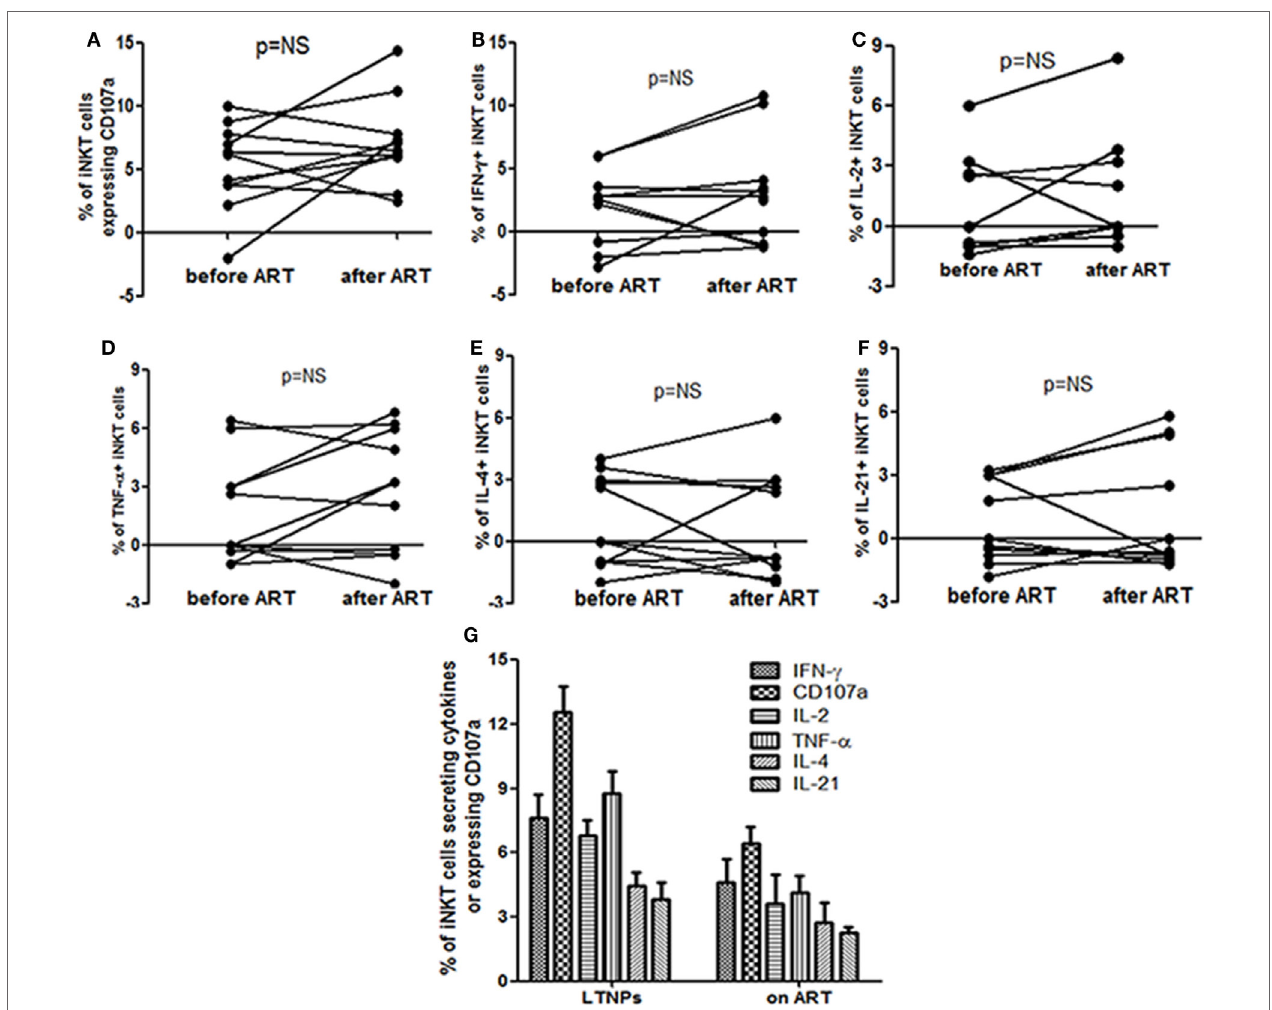
FigUre 3 | Assessment the impact of anti-retroviral treatment (ART) on the functionality of invariant natural killer T (iNKT) cells: the figure shows percent of (a) CD107a + iNKT cells (B) , IFN- γ secreting iNKT cells (c) , IL-2 secreting iNKT cells (D) , TNF- α secreting iNKT cells (e) , IL-4 secreting iNKT cells, and (F) IL-21 secreting iNKT before and at 12 months after ART. All the comparisons were done using the Wilcoxon’s signed-rank test on 12 matched samples. (g) Comparison of α -GalCer stimulated iNKT cell frequencies secreting IFN- γ , TNF- α , IL-2, IL-4, and/or IL-21 and expressing CD107a on the Y -axis in long- term non progressors and at 12 months post